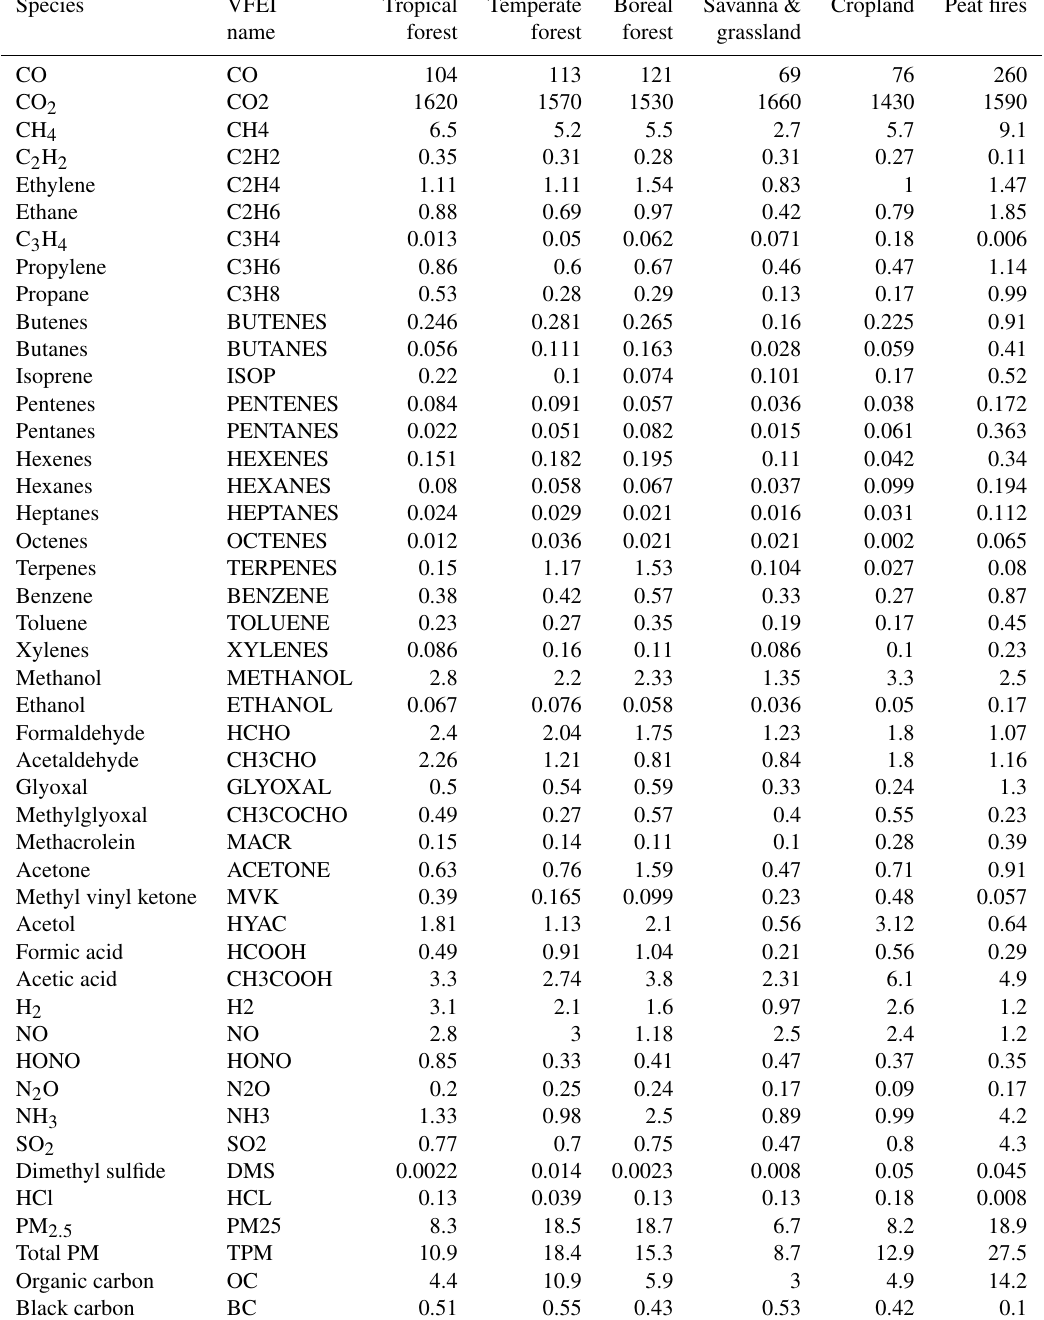
Table 1. Species considered by VFEI and their emission factors (gkg − 1 ) compiled by Andreae (2019). Species VFEI Tropical Temperate Boreal Savanna & Cropland Peat fires name forest forest forest